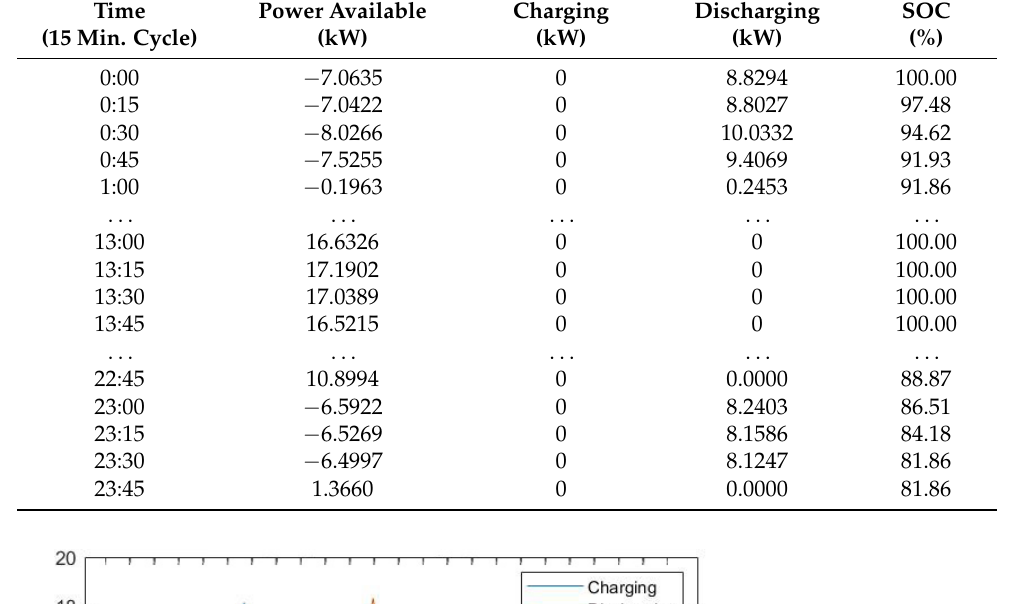
Table 10. Power available, Charging, Discharging and SOC values in CSPVND.